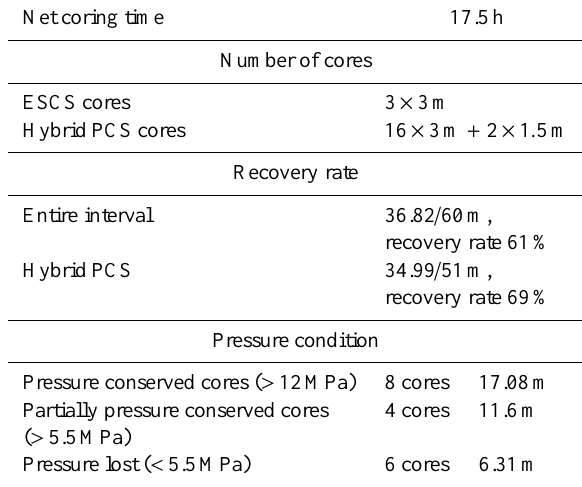
Table 3b. Place of analysis for pressurized and depressurized cores.